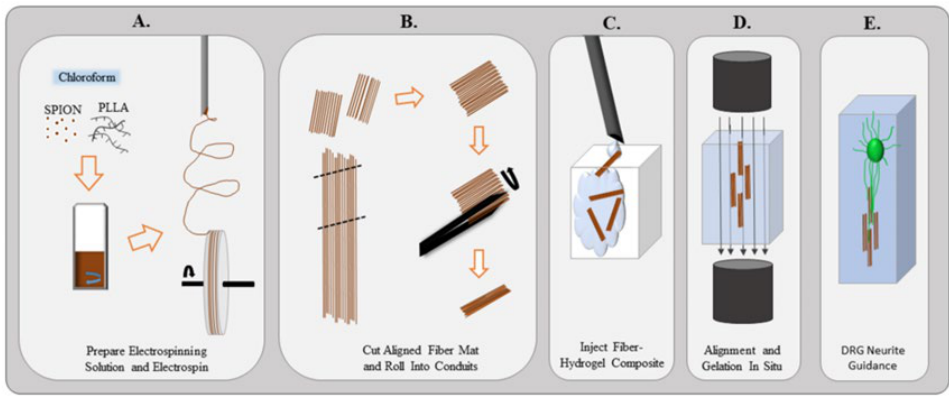
Figure 4. ( A ) Superparamagnetic iron oxide nanoparticles are mixed into the PLLA electrospinning solution and chloroform. Once dissolved, the solution is created an aligned fiber mat. ( B ) Mat is removed from the wheel and cut into segments. Using forceps, the fiber mats are rolled into a small conduit. ( C ) Small conduits and hydrogel are injected into a chamber. ( D ) Magnetic field is applied to orient the fibers within the hydrogel in situ. ( E ) Magnetic field is removed and the fibers remain aligned to guide neurites extending from the dorsal root ganglion. Adopted with permission from ref. [88].